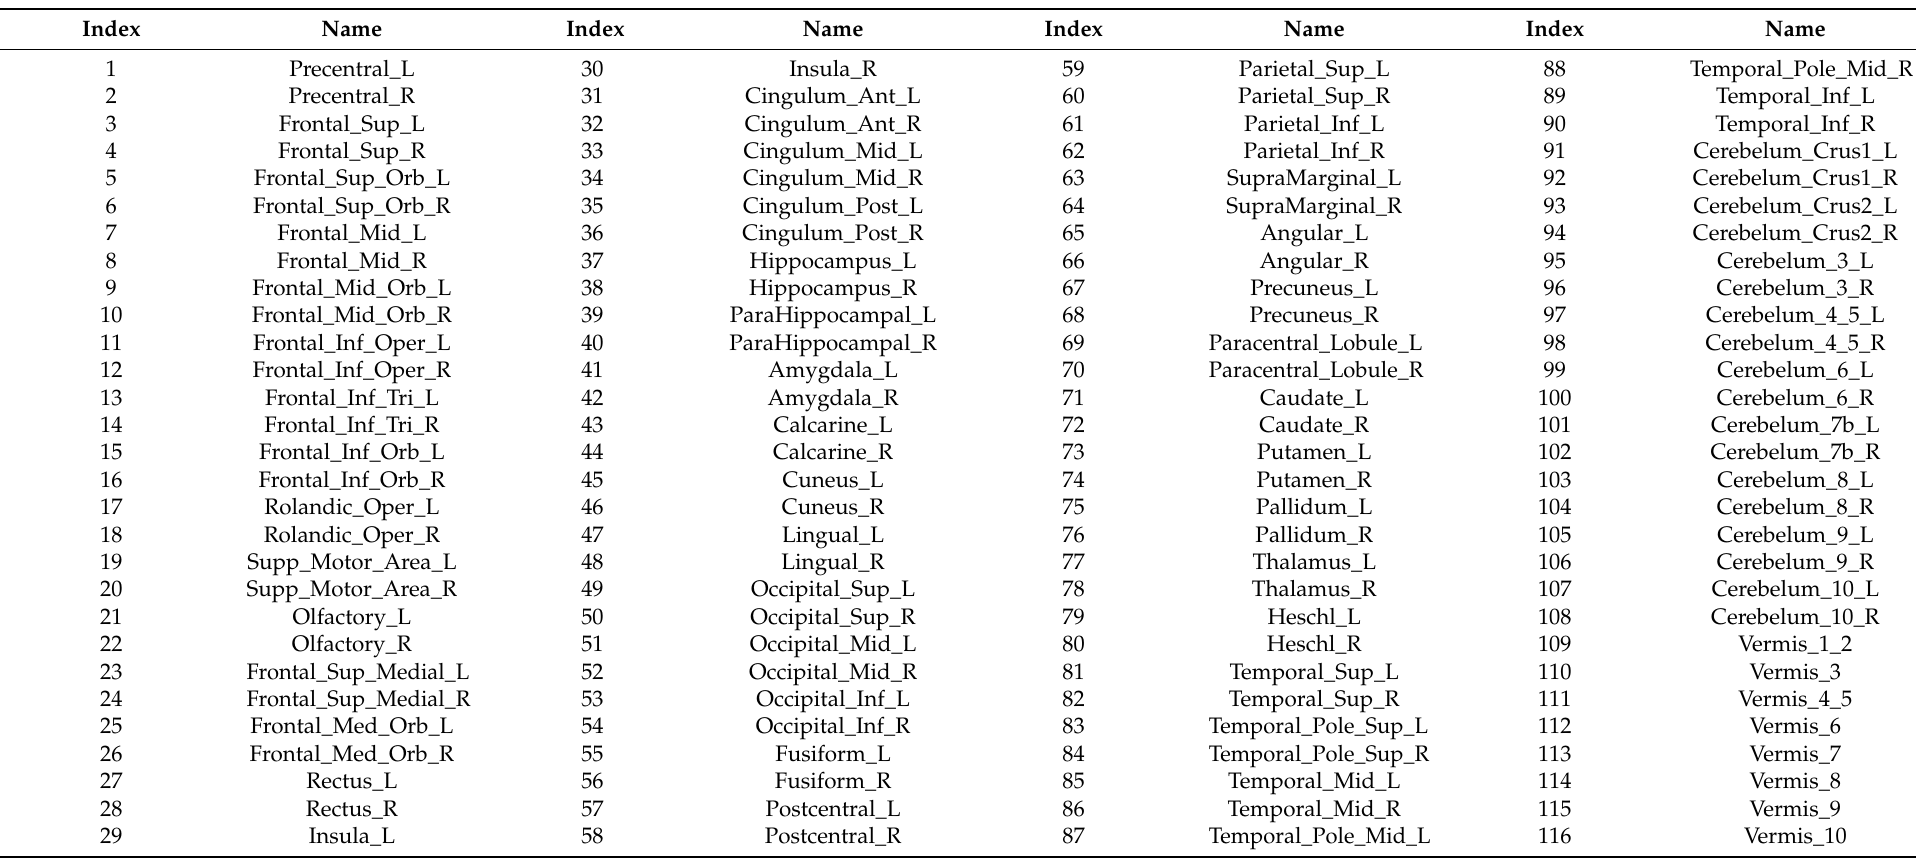
Table A3. Region of interest order. This table includes 116 regions of interest in the brain. The SNP-QT association maps shown in Figure 2 have a horizontal axis that follows the order